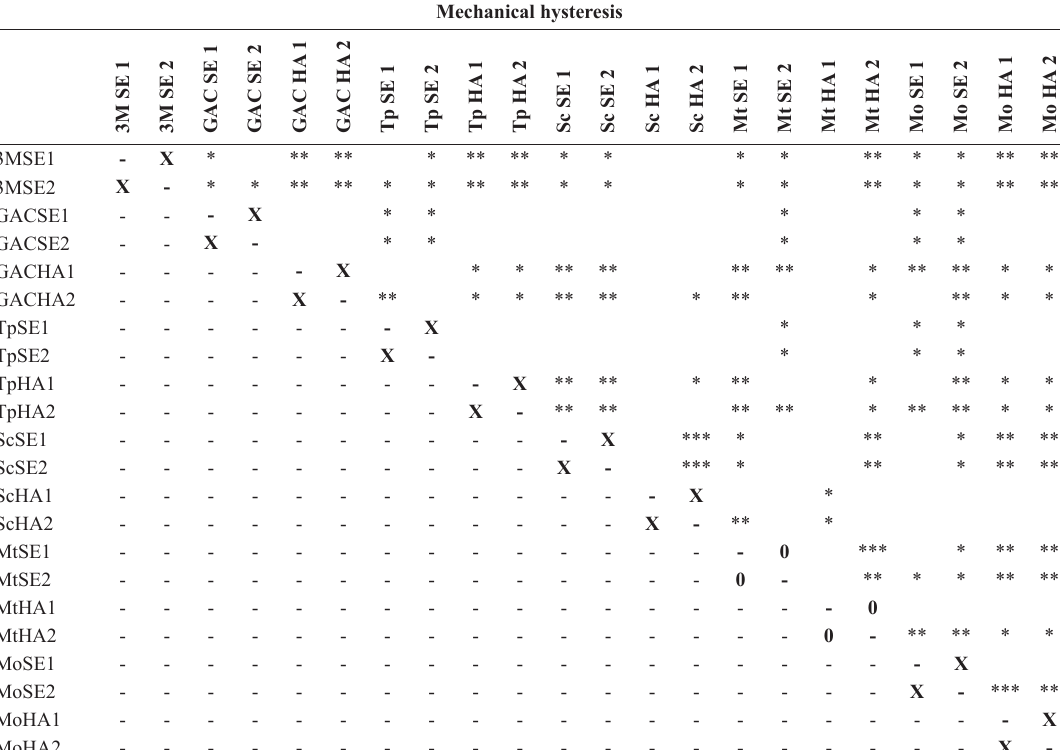
Table 9. Mechanical hysteresis comparison among different groups and commercial lots by Tukey test (p=0.05). Mechanical